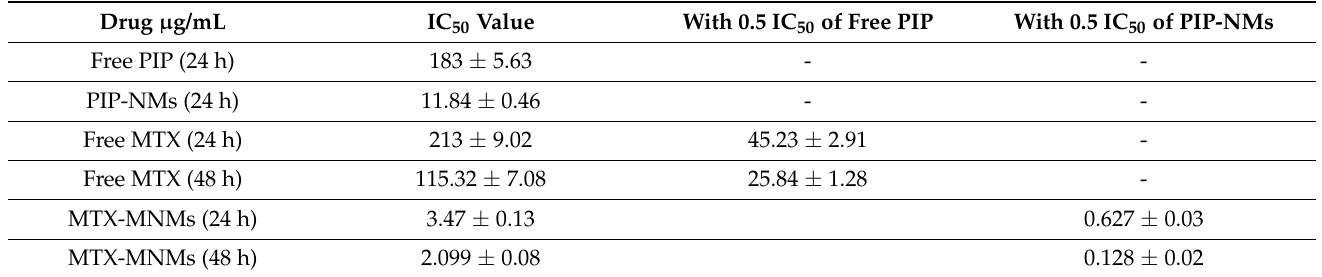
Table 2. Cytotoxicity results of free drugs (PIP and MTX), PIP-NMs and MTX-MNMs at 24 and 48 h.